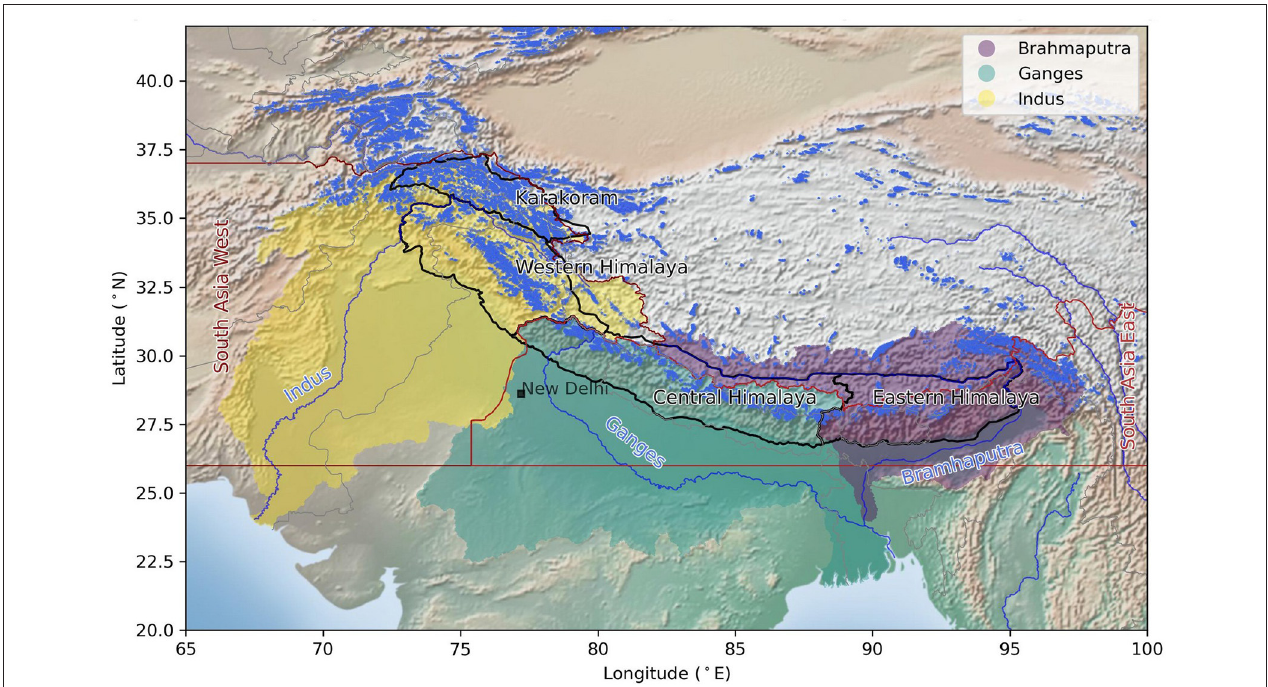
FIGURE 1 | Map of the Himalayan River Basins—Indus, Ganga and Brahmaputra—feeding from the glaciers. The glacier cover (blue patches) is based on Randolph Glacier Inventory 6.0 ( RGI Consortium, 2017). The background is the Stamen terrain map, the Himalayan region subdivision from Bolch et al. (2019a), river basin boundaries are based on the International Center for Integrated Mountain Development ( ICIMOD, 2021), and river central lines are from the Global High-Resolution River Centerlines (USGS). RGI’s first order regions 14 (South Asia West) and 15 (South Asia East) are also shown (red